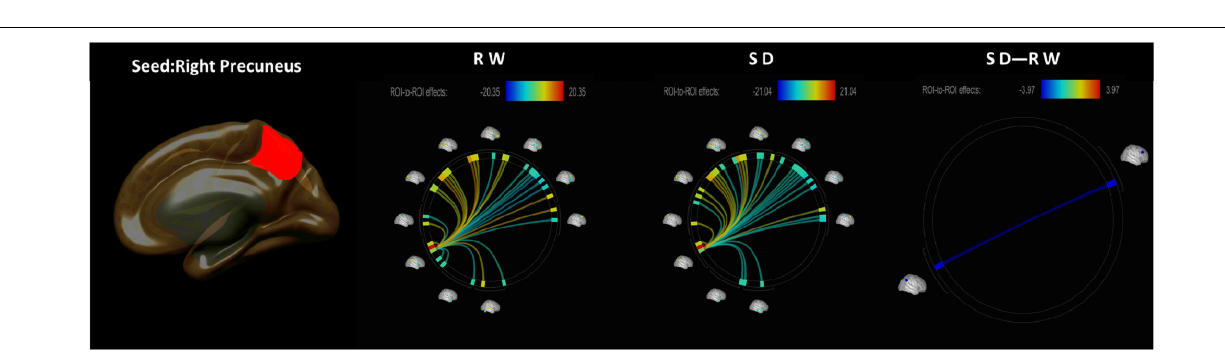
FIGURE 2 | ROI-to-ROI functional connectivity of the right precuneus during the RW, SD, and SD > RW conditions. False discovery rate-corrected ( p < 0.05) for ROI-to-ROI tests. ROI, region of interest; SD, sleep deprivation; RW, rested wakefulness. TABLE 2 | ROI-to-ROI functional connectivity statistics for an individual seed region: comparisons between SD and RW scans ( t -test). Target